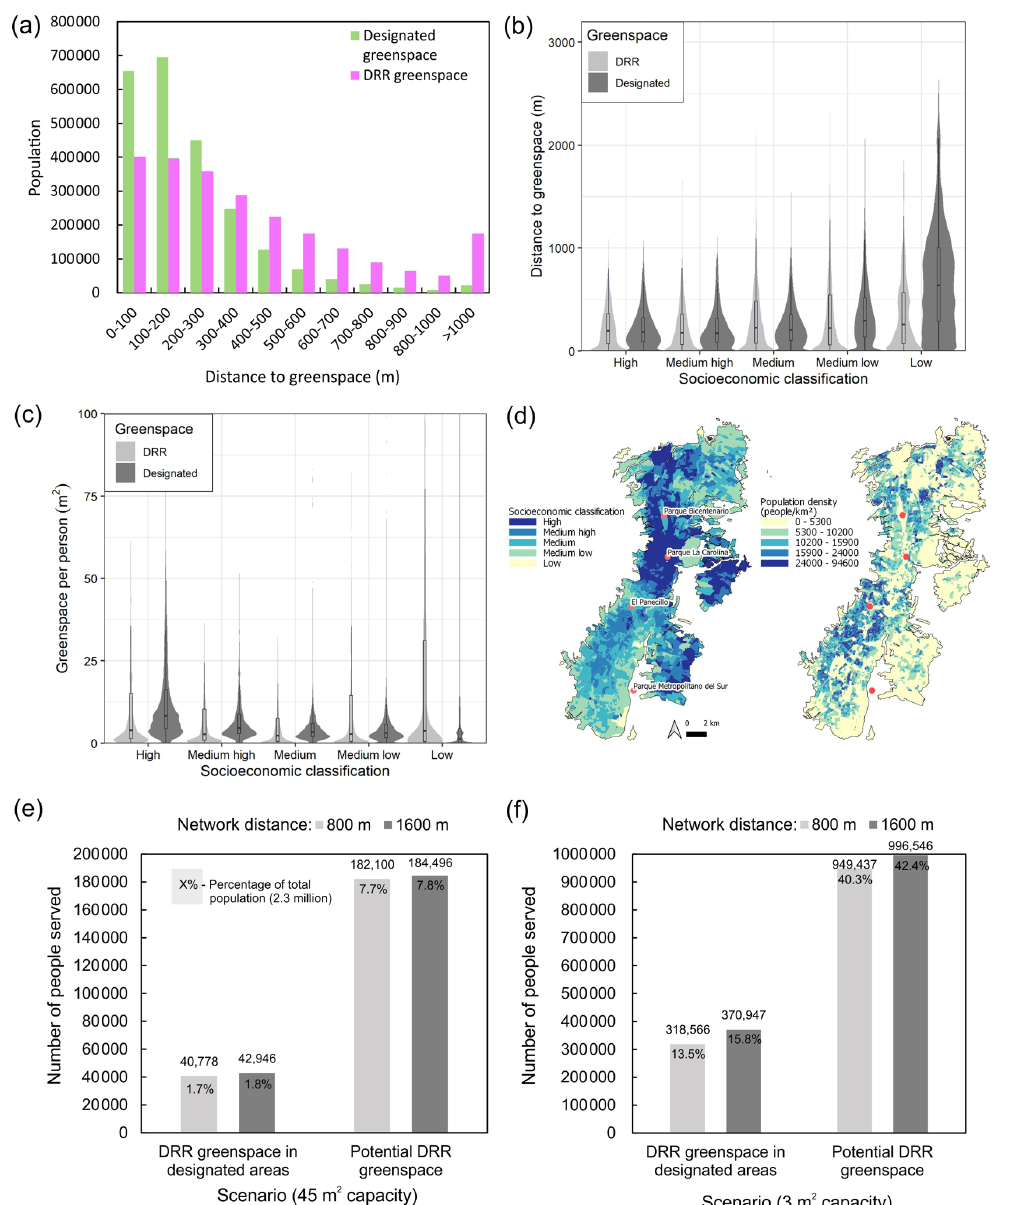
Figure 9. (a) Population proximity to designated and DRR greenspace. (b) Violin plot showing distance to the nearest greenspace for each socio-economic classification. Overlaid boxplots show the interquartile range and the median (horizontal line). Lines show values within 1.5 times the interquartile range. Outliers are excluded. (c) Violin plot showing greenspace per person within 800m for each socio-economic classification. Boxplots are overlaid with outliers excluded, and values > 100m 2 per person are not shown. (d) Spatial variation in socio- economic classification and population density for Quito using data from the Instituto Geográfico Militar (2019). (e) Number of people that could be accommodated in DRR greenspace based on an allocation of 45m 2 per person capacity and (f) 3m 2 per person capacity. Panels (e– f) show capacitated populations for a network distance of 800m (light grey bars) and 1600m (dark grey bars) from the greenspace centroid and for DRR greenspace in designated spaces compared to all potential DRR greenspace mapped in this